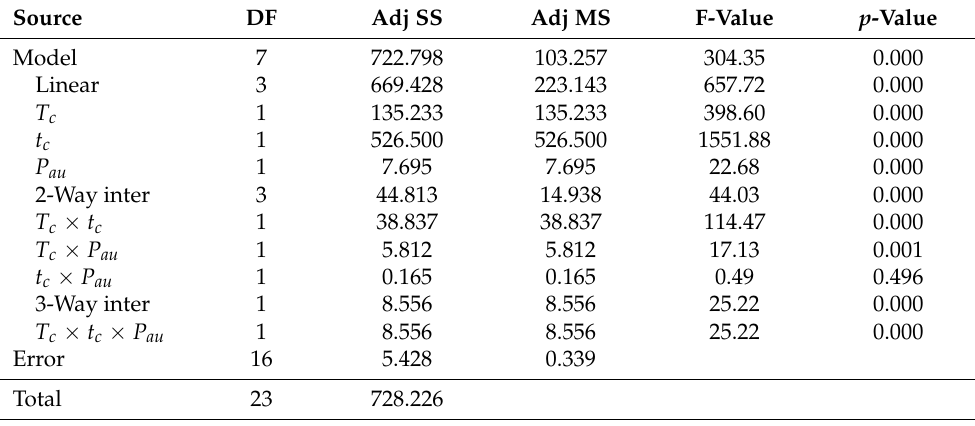
Table 4. ANOVA results for impact strength. It was observed that all main effects and three-way interactions were found significant ( p -value < 0.05) for the impact toughness of the CFRP.